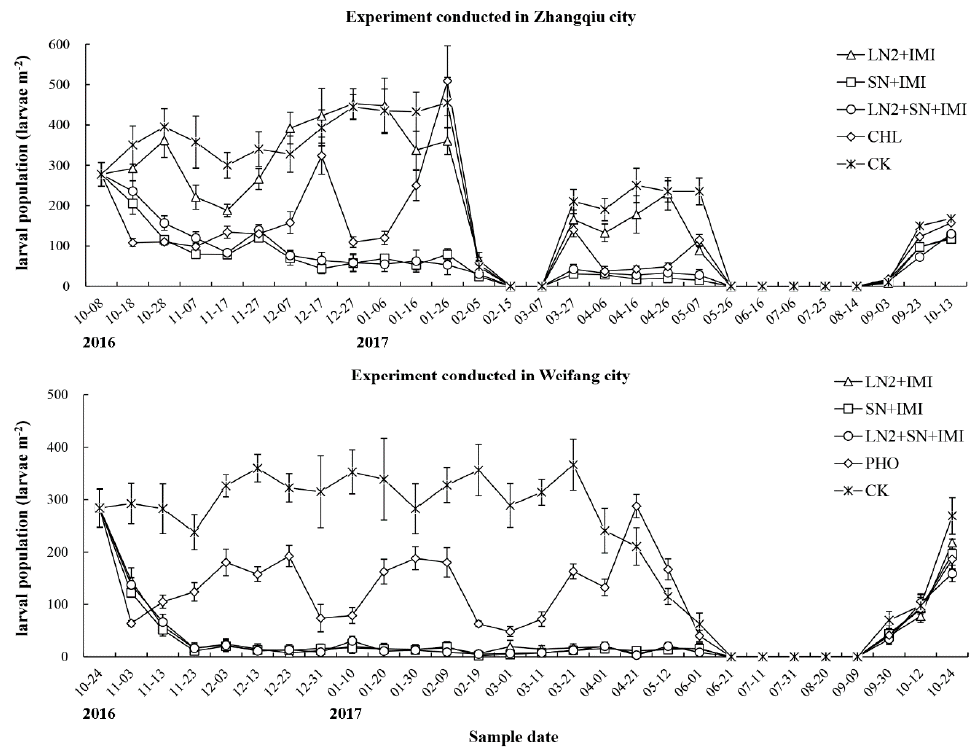
Figure 4. The larval population of Bradysia odoriphaga recovered from field surveys in the experiments conducted in Zhangqiu and Weifang city in China, in 2016–2017. LN2: Heterorhabditis indica LN2 applied at 3.0 × 10 9 IJ · ha − 1 ; SN: Steinernema feltiae SN applied at 3.0 × 10 9 IJ · ha − 1 ; Imi: imidacloprid applied at 1 / 10 recommended field rate (4.5 g · ha − 1 ); SN + LN2: both H. indica LN2 and S. feltiae SN applied at 1.5 × 10 9 IJ · ha − 1 ; CHL: chlorbenzuron applied at the recommended field rate of 15 mg · kg − 1 ; PHO: phoxim applied at the recommended field rate of 1125 mL · ha; CK, water